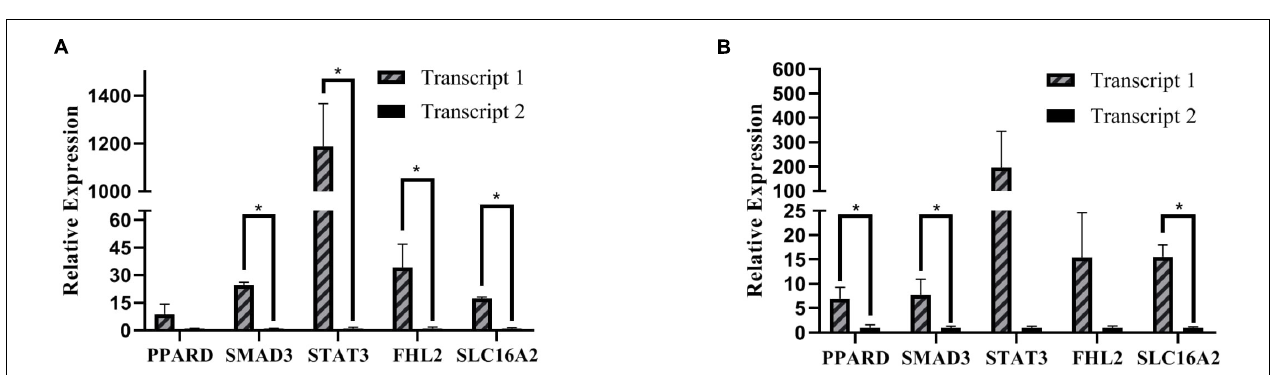
FIGURE 11 | RT-qPCR relative expression. (A) Expression of different transcripts of subcutaneous adipose. (B) Expression of different transcripts of abdominal adipose, * P < 0.05.